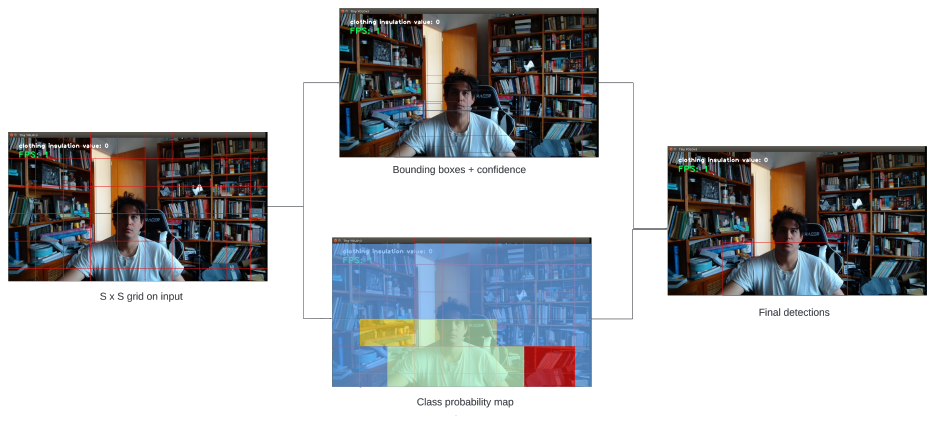
Figure 1. YOLO method.